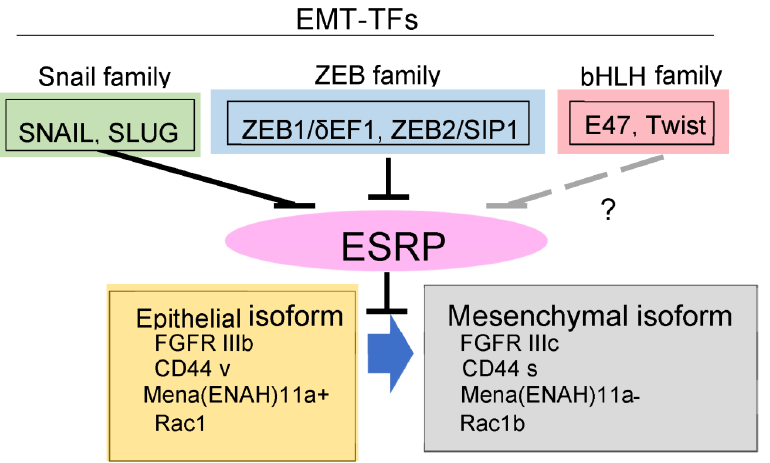
Figure 3. Schematic illustrations of EMT regulated by EMT transcription factors (EMT-TFs). Up- regulation of EMT-TFs decreases expression of ESRPs, and subsequently changes in alternative splicing events during EMT. FGFR, fibroblast growth factor receptor; Mena (also known as ENAH), a member of the Enabled (Ena)/vasodilator-stimulated phosphoprotein (VASP) family of proteins; Rac1, RAS-Related C3 Botulinum Toxin Substrate